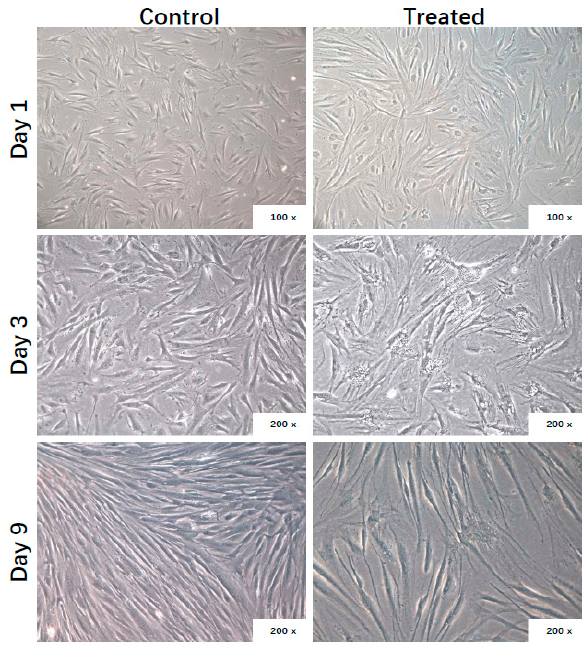
Figure 1. Effect of inflammation on ADHLSC culture. Morphology of ADHLSC observed microscopically after different times post-treatment with the inflammation cocktail ( n = 6 samples from different donors). Magnification: 100× and 200×.